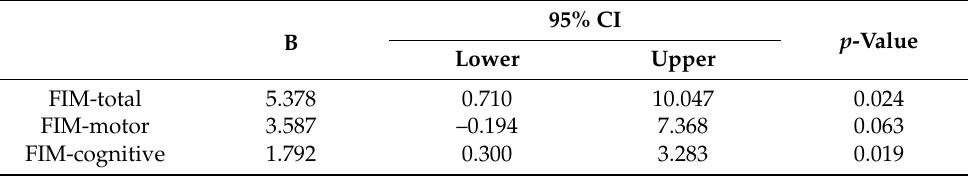
Table 3. Multiple linear regression analysis for FIM-total, FIM-motor and FIM-cognitive in 227 post-stroke older patients with sarcopenia. The association between each outcome and improvement in sarcopenia was determined. 95% CI p -Value B Lower Upper FIM-total 5.378 0.710 10.047 0.024 FIM-motor 3.587 –0.194 7.368 0.063 FIM-cognitive 1.792 0.300 3.283